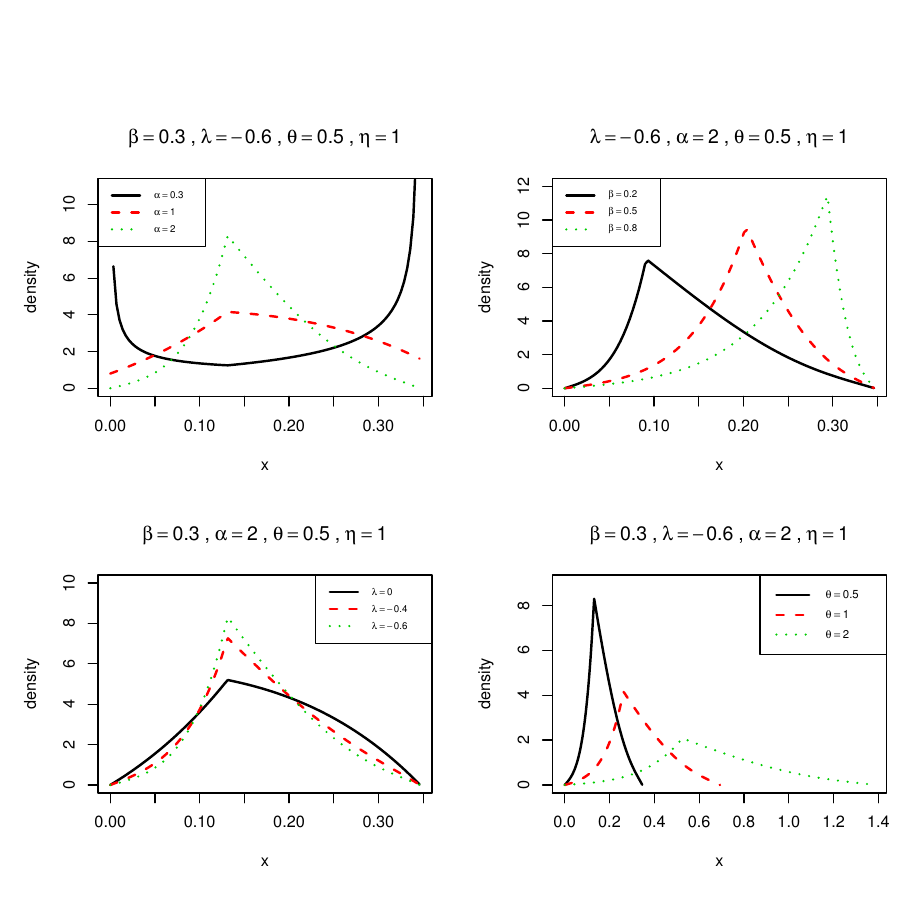
Figure 2 – The graphs of the densities of the GOTTS-E distribution with − 1 ≤ λ ≤